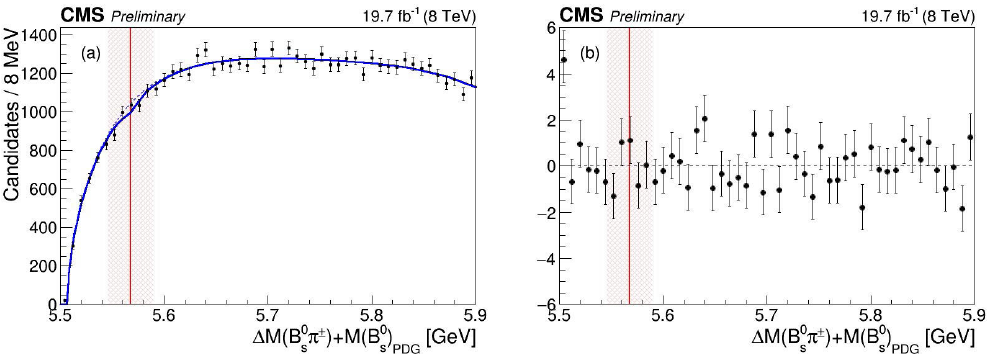
Figure 3. (left) Mass distribution of events in the B s signal region (black points with error bars) with fit results superimposed (blue line).(right) The pull distribution for (left): the (red) vertical band indicates the region of the D ∅ observation around the mass of the claimed